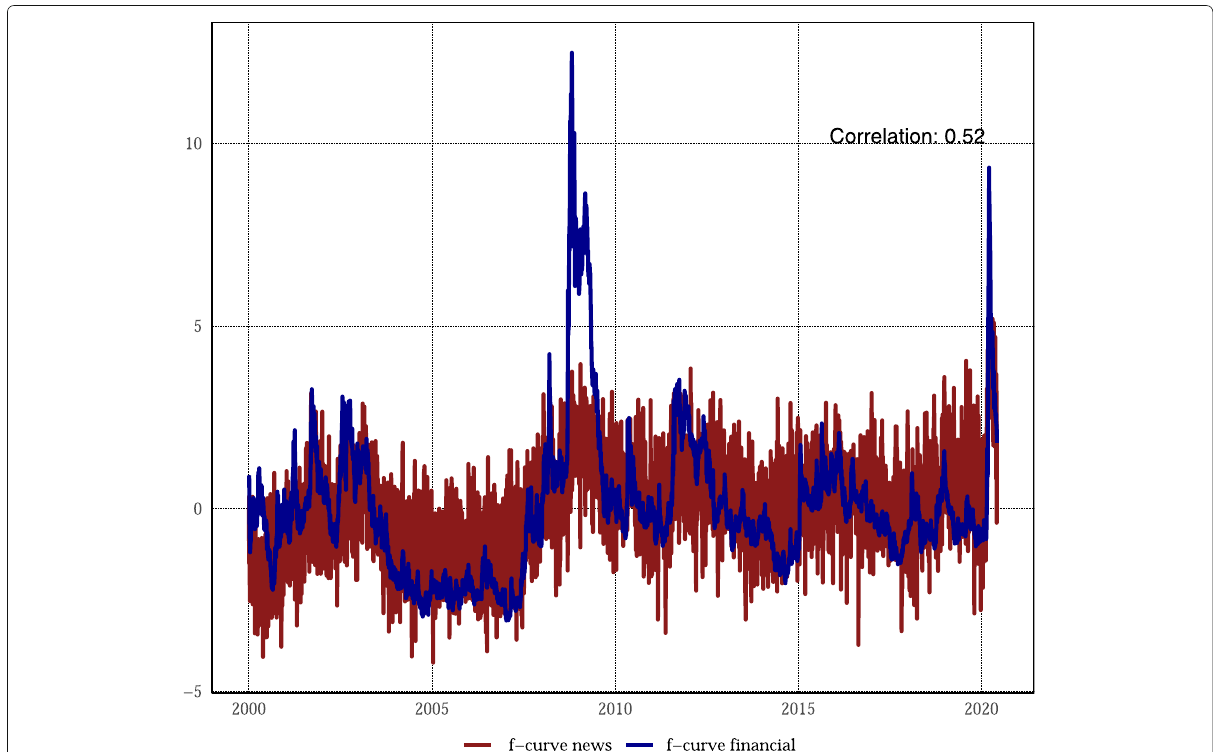
Fig. 4 Comparison news and financial market data. Two indicators estimated only on financial market and news data, respectively